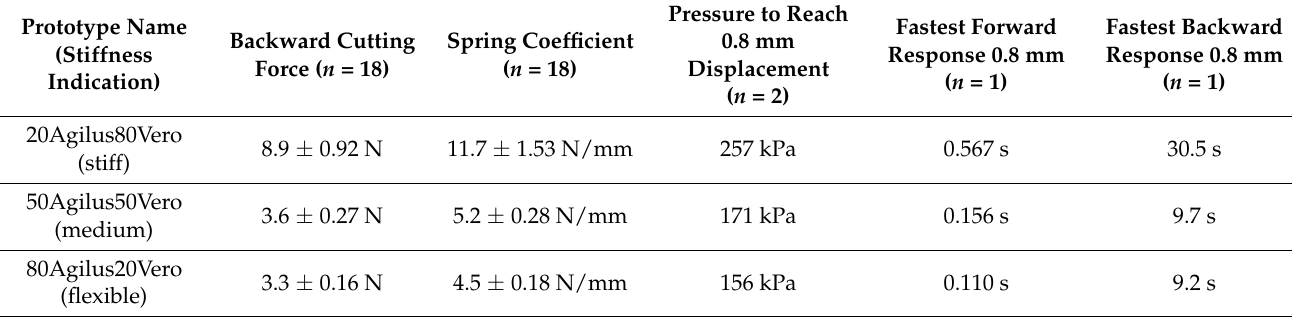
Table 2. Results of the digital material diaphragms, showing the average backward cutting force, the average spring coefficient, and the average pressure required to displace the carrier by 0.8 mm. In addition, the fastest obtained forward and backward response for a displacement of 0.8 mm are